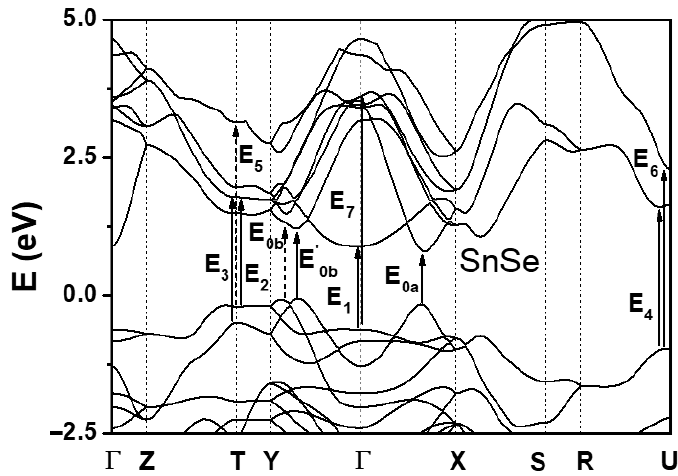
Figure 10. The calculated energy band structure of SnSe. Band-to-band transitions are shown by arrows. The dashed line is E 0 b .